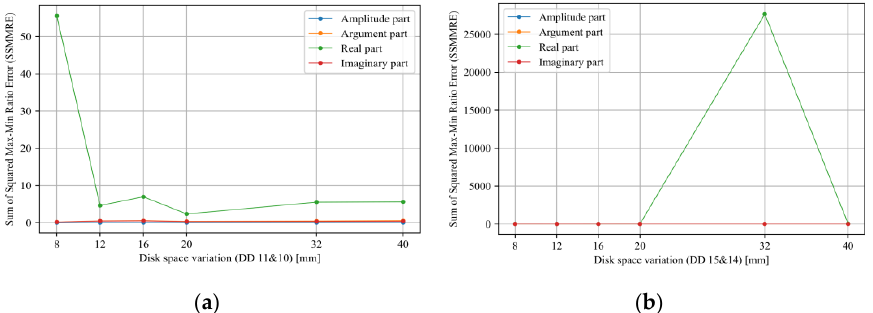
Figure 19. Feature variations based on the severity of the DSV fault in different locations for extracted by the SSMMRE index: ( a ) DSV in DD 11 and 10 ( b ) DSV in DD 15 and 14.